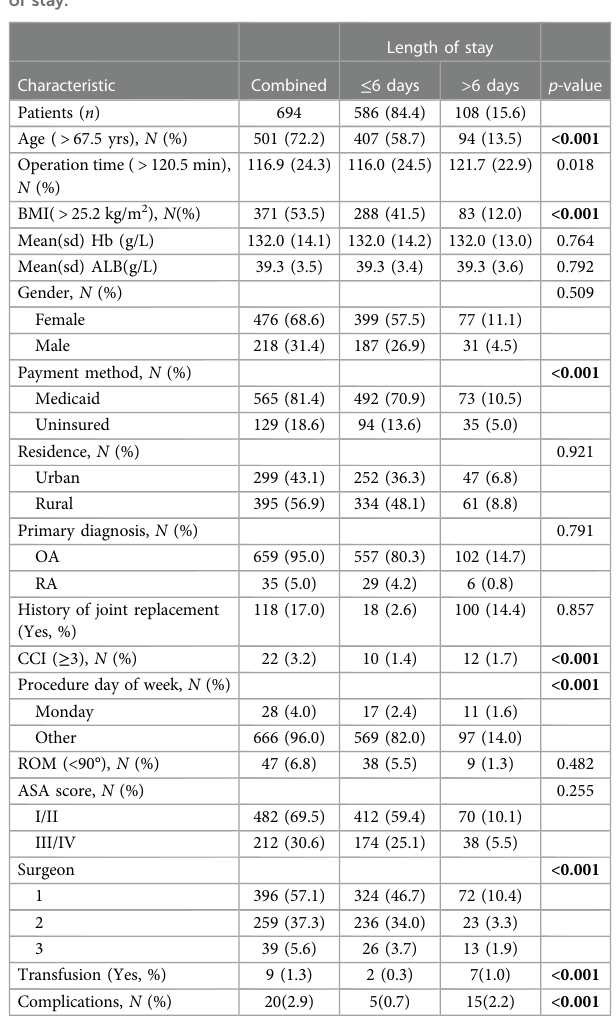
TABLE 1 Demographics and clinical characteristics of patients by length of